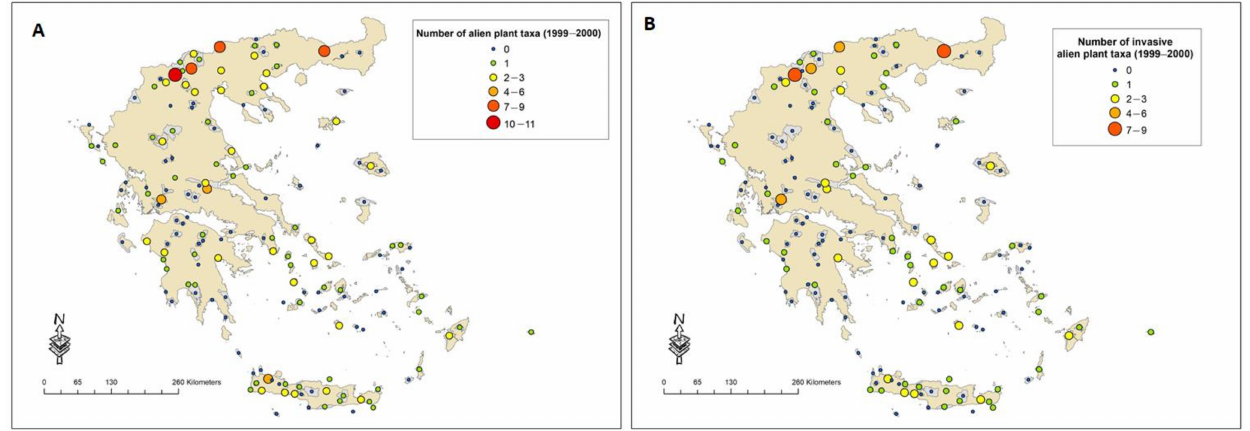
Figure 1. Number of alien plant taxa ( A ) and IAPS ( B ) recorded in each site during period A (1999–2000).